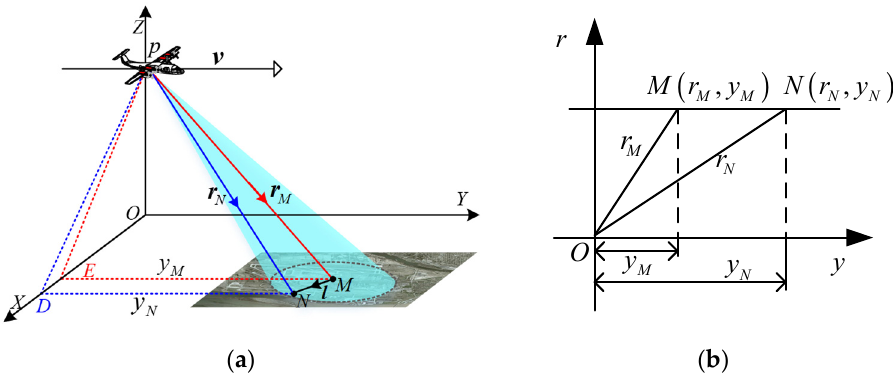
Figure 1. Squinted SAR imaging geometry in ( a ) Cartesian and ( b ) Slant-range plane coordinates.